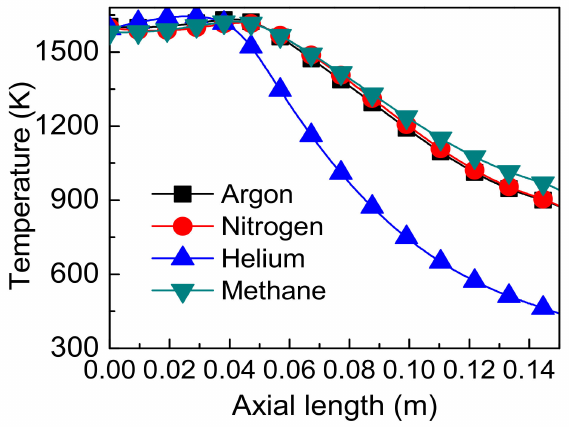
Figure 11. The distribution of temperature in the cavity of di ff erent gases at absorption = 0.01, 150 kW / m 2 radiation flux source and 1